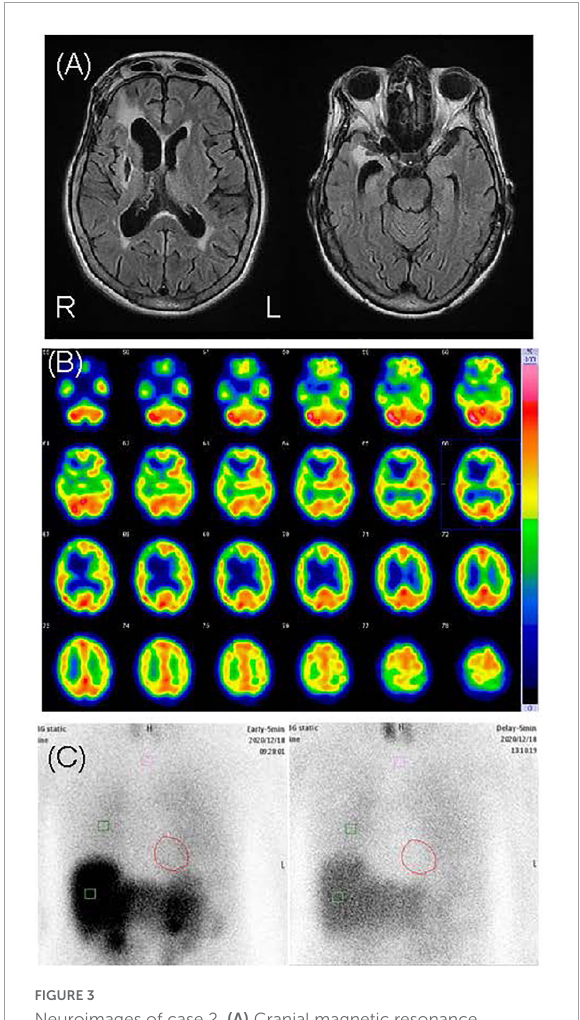
FIGURE3 Neuroimages of case 2. (A) Cranial magnetic resonance revealed right dominant bilateral diffuse atrophy and right putamen chronic hemorrhage. (B) N-isopropyl-p-[ 123 I] iodoamphetamine single-photon emission computed tomography revealed hypoperfusion in the right basal ganglia and the frontal, temporal, and parietal lobes. (C) Cardiac [ 123 I]-metaiodobenzylguanidine scintigraphy revealed heart-to-mediastinum ratios of 1.91 and 1.32 in the early and delayed phases,